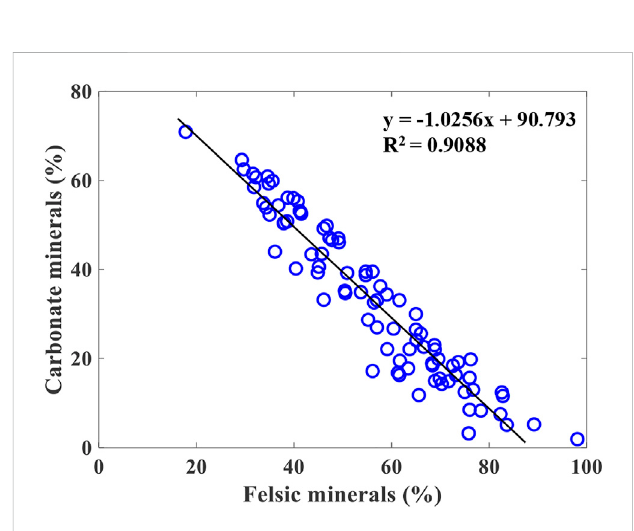
The plot of felsic minerals and carbonate